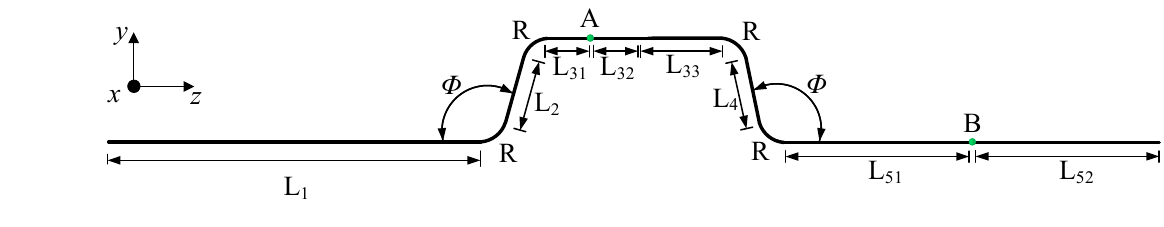
Figure 6. Analysis model of the aircraft hydraulic pipe. Table 1. Physical parameters of the pipe and fluid.